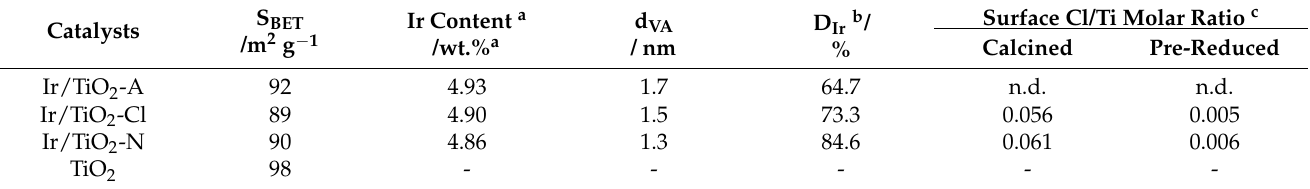
Table 1. The summary of physical properties of TiO 2 -{101} NCs and various pre-reduced Ir/TiO2 catalysts.